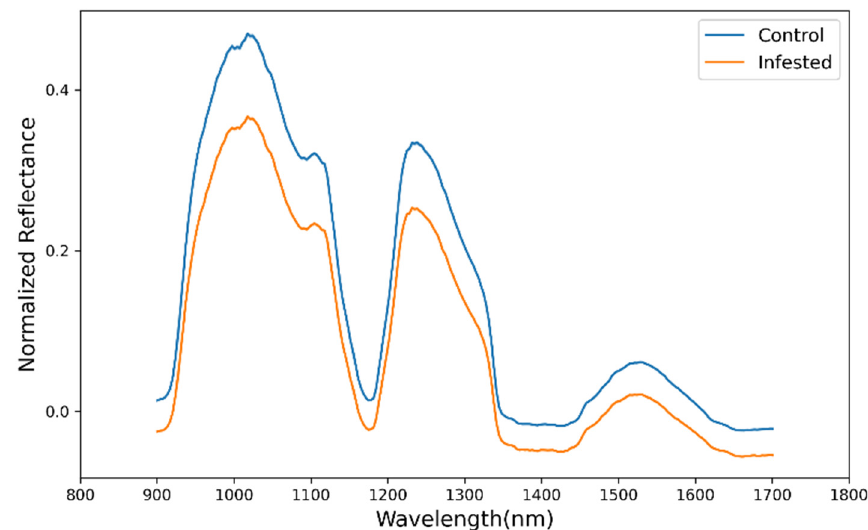
Figure 3. Mean reflectance spectra of control and CM-infested samples acquired by near-infrared hyperspectral imaging (NIR HIS). CM: codling moth. hyperspectral imaging (NIR HIS). CM: codling